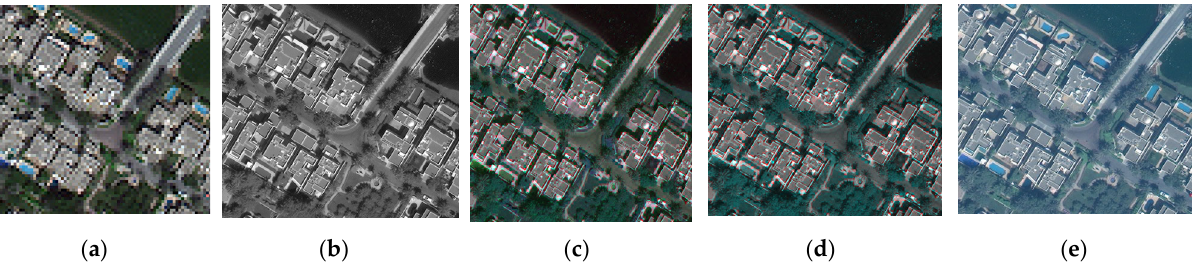
Figure 3. Particular images (bands: 5, 3, 2) of LRMS ( a ), PAN ( b ), IHS ( c ), Brovey ( d ) and Gram–Schmidt ( e ). The quality indexes (RMSE, RASE and ERGAS) obtained on WV ‐ 2 images and calcu ‐